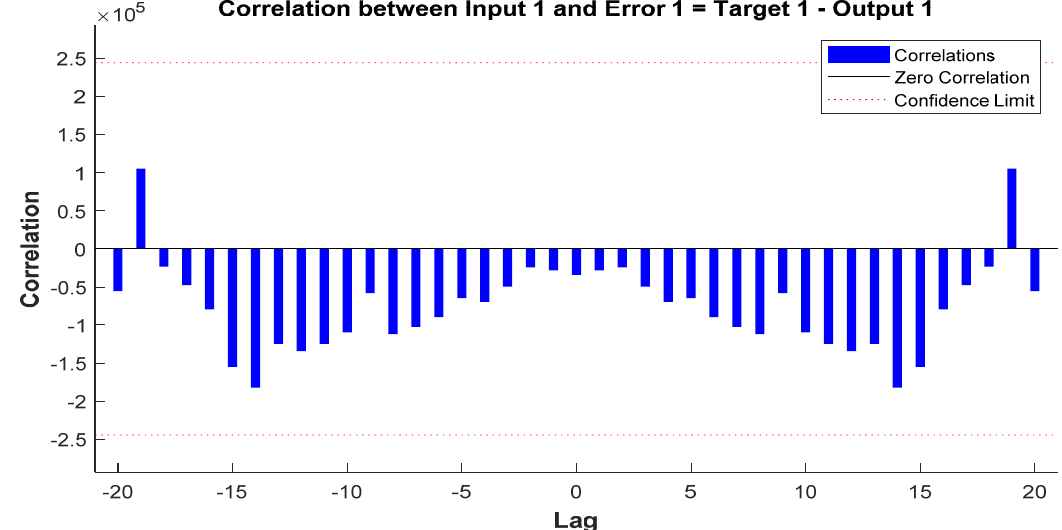
Figure 7. The cross-correlation functions (CCFs) for the aforementioned dataset using the best possible regression order.